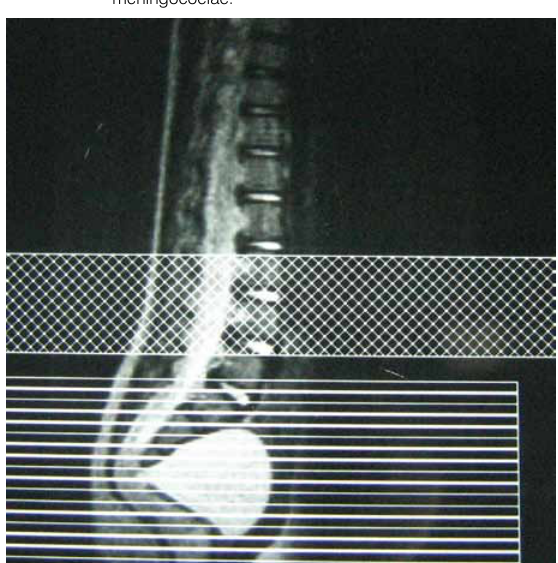
Figure 1. Plain radiograph of the sacrum demonstrating sacral agenesis with absence of third, fourth and, fifth segments on the left side (shape of the scimitar)